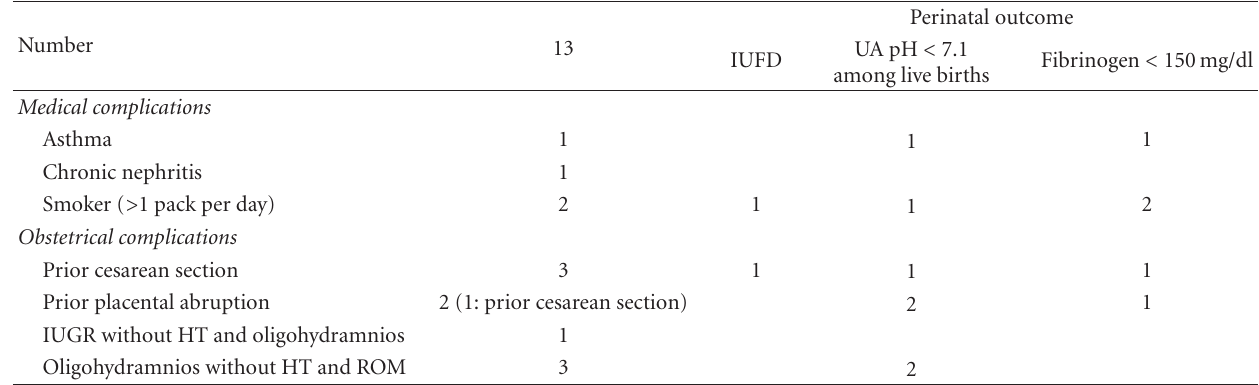
Table 1: Medical and obstetrical complications in the others group.